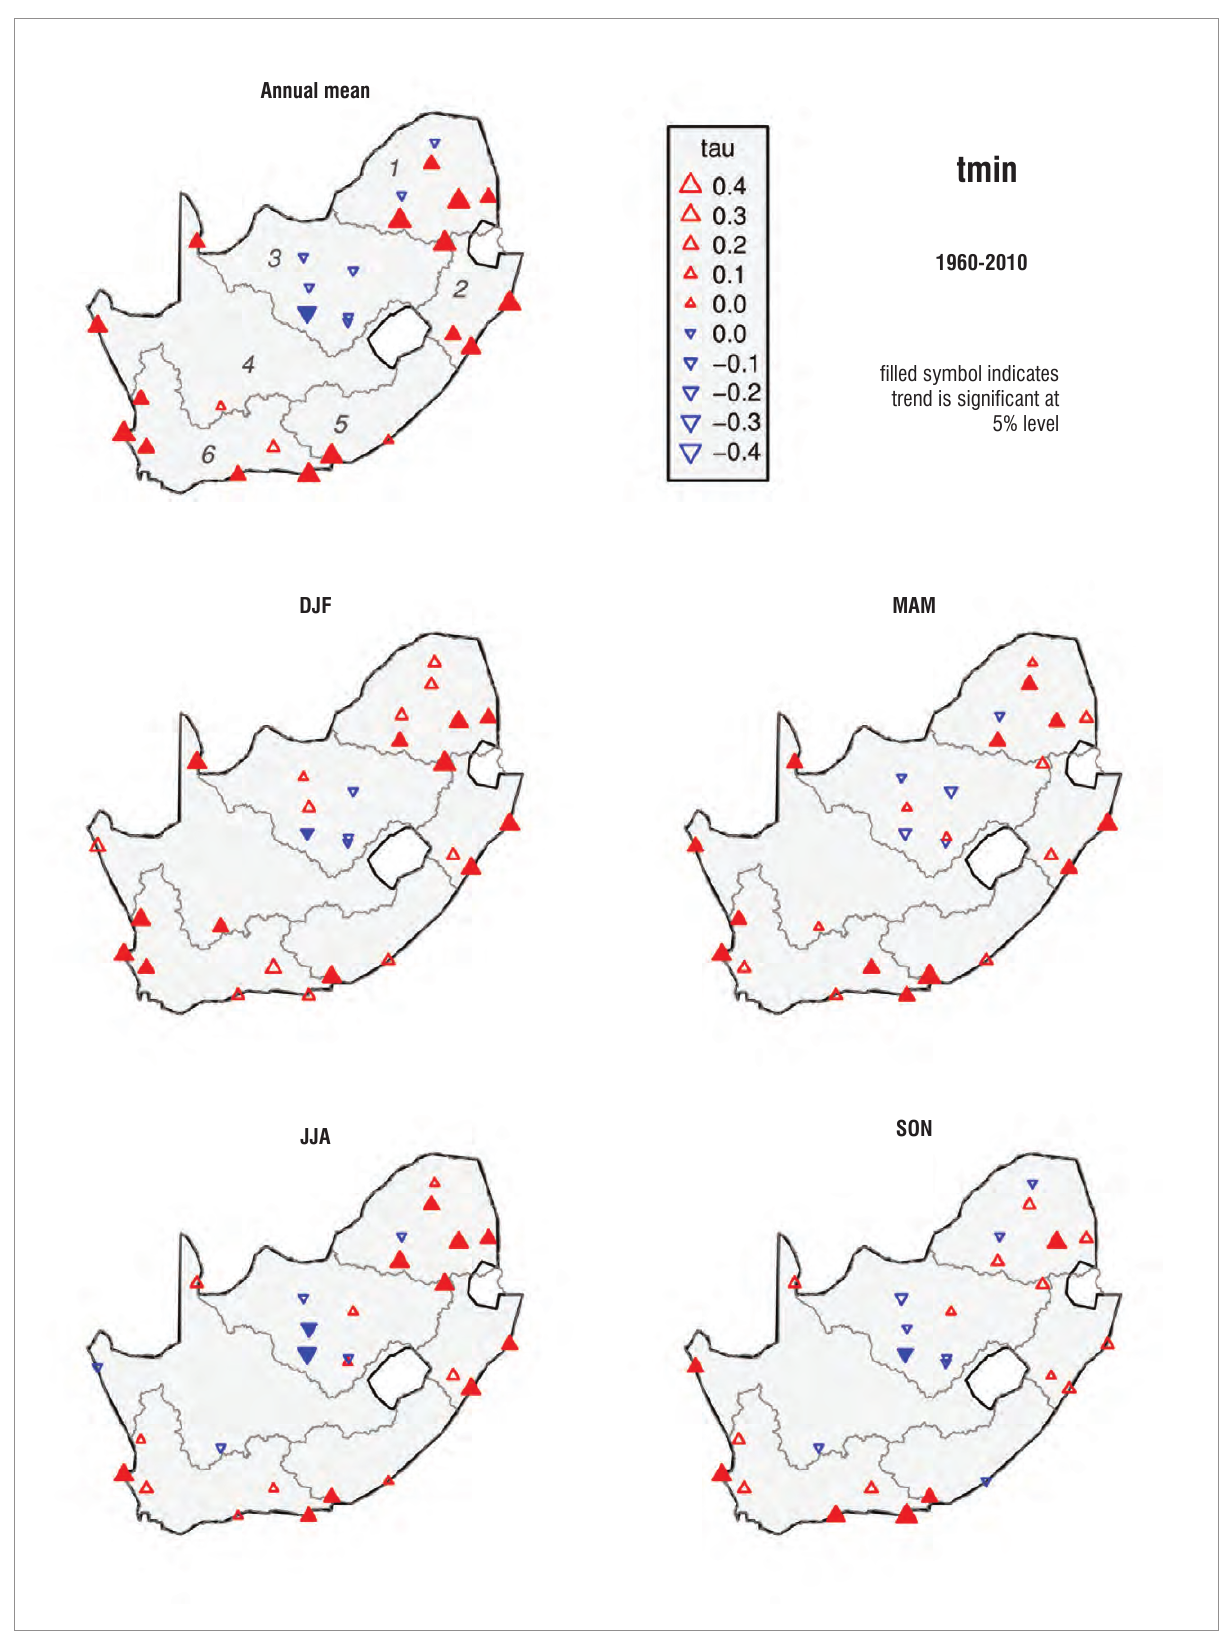
Figure 4: Trends in annual and seasonal mean daily minimum temperature (tmin, °C) for each station according to the Mann–Kendall test. The value of tau represents the direction and relative strength of the trend. Shaded symbols denote trends that are significant at the 5% level. Seasons are summer (DJF), autumn (MAM), winter (JJA) and spring (SON). Grey borders represent boundaries of the six water management regions, which are identified by number (1–6) in the annual mean